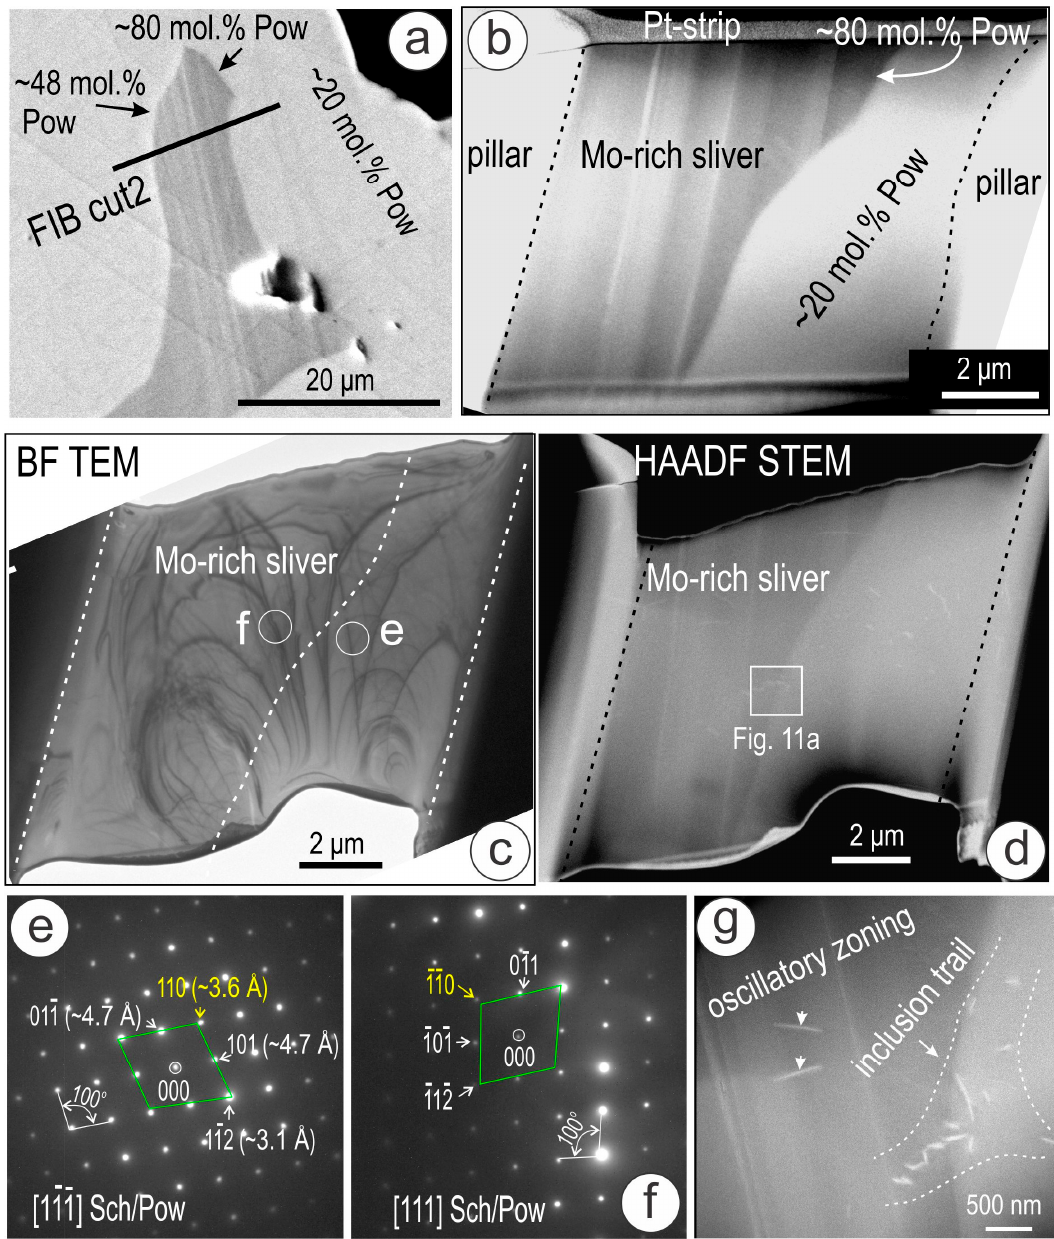
Figure 10. ( a – d ) Plan and depth views of the area sampled for the highest powellite (Pow) content as marked. Note correlation between oscillatory zoning on SE image ( b ) and HAADF STEM image ( d – f ). SAEDs obtained from Mo-rich sliver and Mo-poor (20 wt.% Pow) matrix showing twinned domains with rotation at ~80° about (011(cid:3364)) * on [11(cid:3364)1(cid:3364)] Sch/Pow zone axis. Note the presence of forbidden reflections marked in yellow. ( g ) HAADF STEM image showing inclusions trails (xenotime-Y) across the sliver boundary.